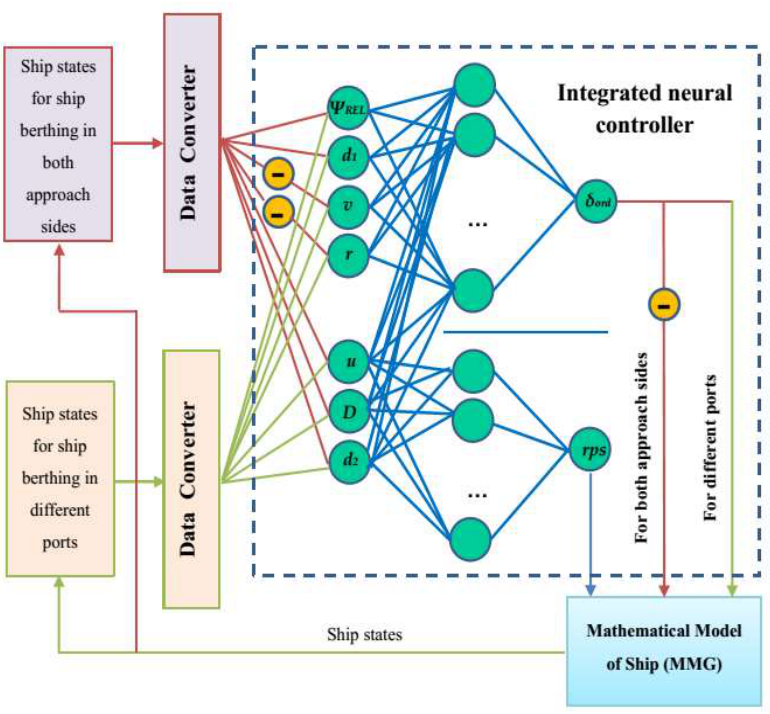
Figure 6. The structure of the multitasking berthing system and the integrated neural controller.